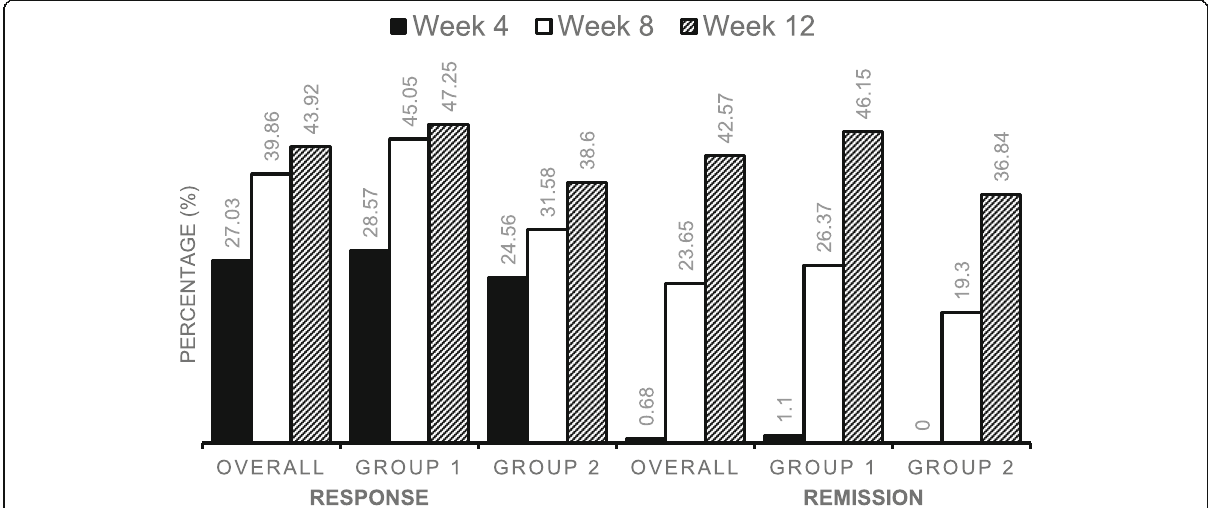
Fig. 1 Percentage of patients showing response and remission during escitalopram therapy. Overall: total study population ( n = 148). Group 1: